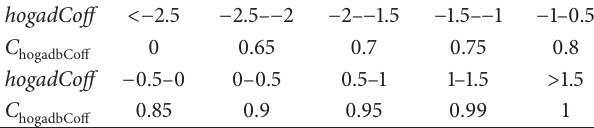
Table 1: Mapping table between 𝐶 𝑠𝑦𝑚𝐶𝑜𝑒𝑓𝑓 and